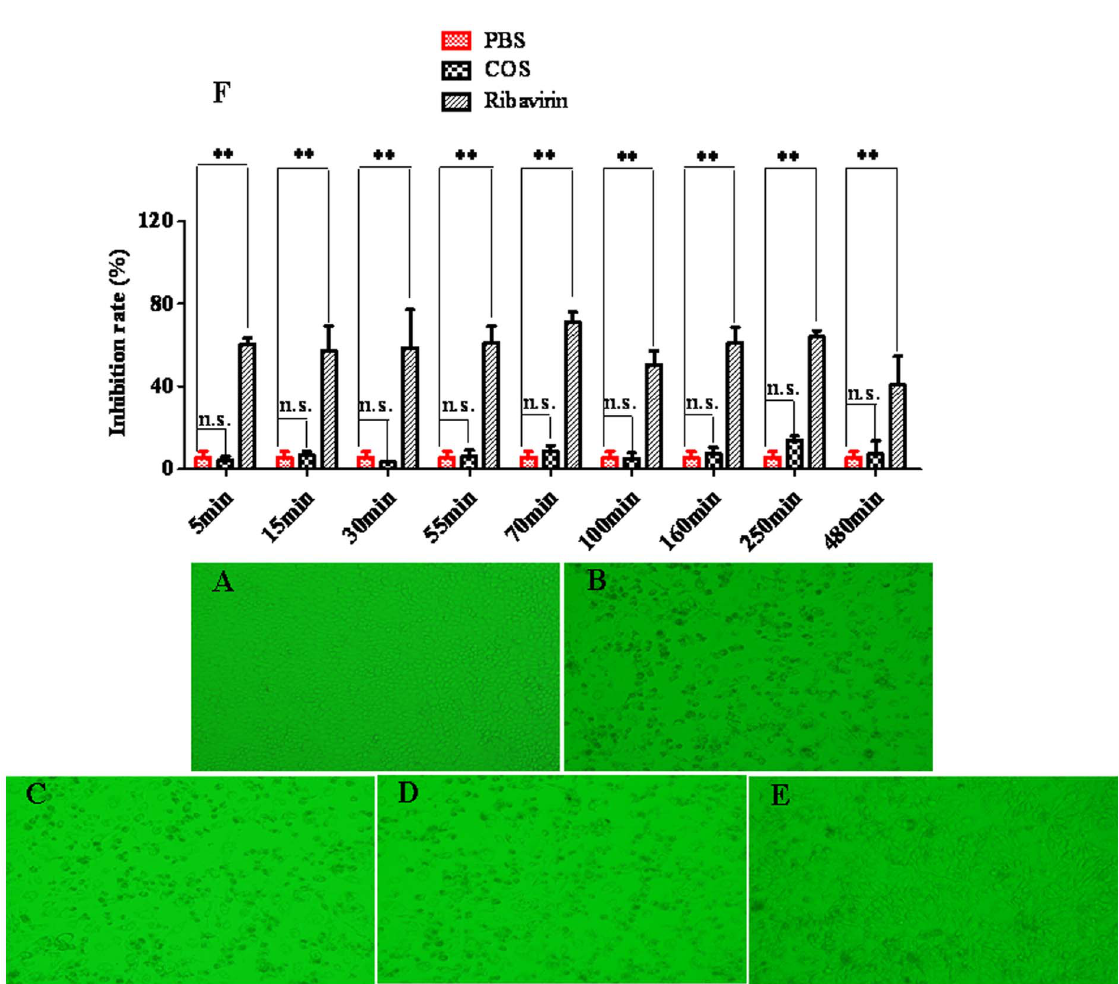
Figure 9. Cytopathogenic effect observed on influenza virus infections in MDCK cells. (A: Normal group; B: Virus group; C: PBS group; D: COS group; E: Ribavirin as positive control group; F: Inhibition rate of COS and ribavirin on influenza virus); Inhibition rate was assayed with MTT 48 hours later and expressed as percentage of controls (data 6 S.D. n =8). ( * ) P , 0.05, ( ** ) P , 0.01 and (N.S.) no significant difference.